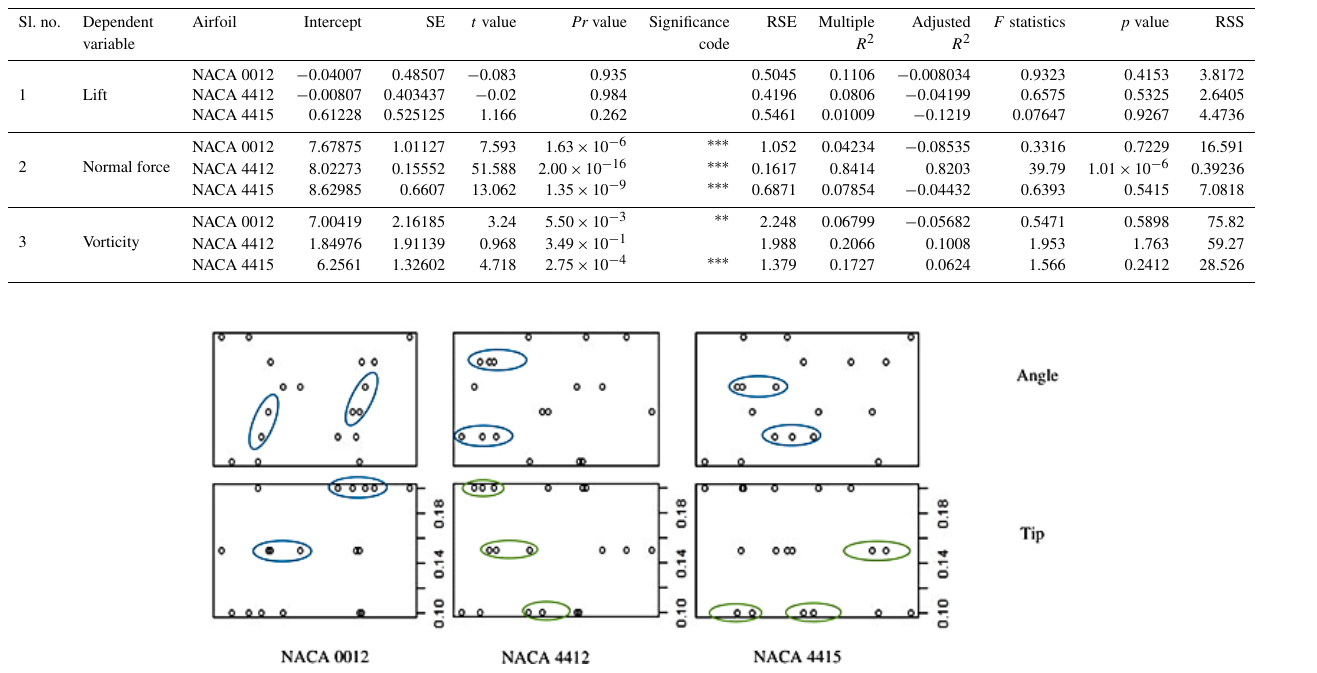
Figure 18. Scatter plot of torque with blade angle and blade tip size of three